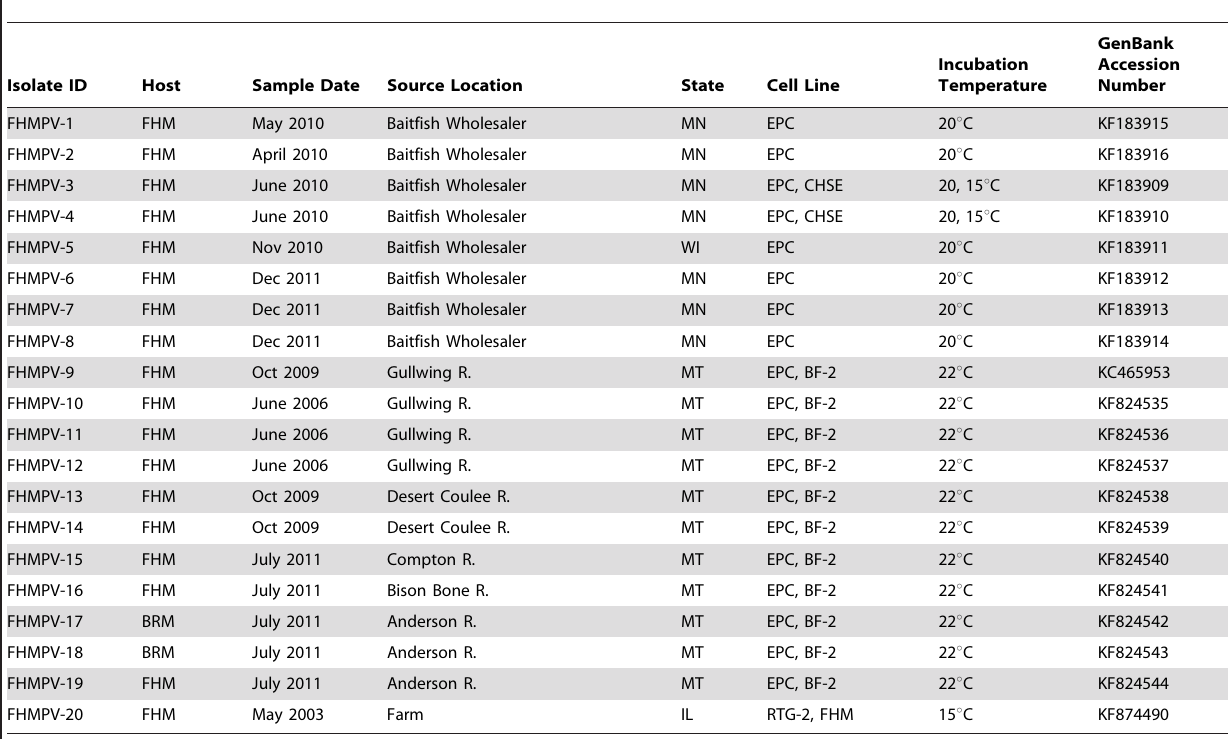
Table 1. Fathead minnow picornavirus isolates included in this study. FHM =fathead minnow, BRM= brassy minnow, R.